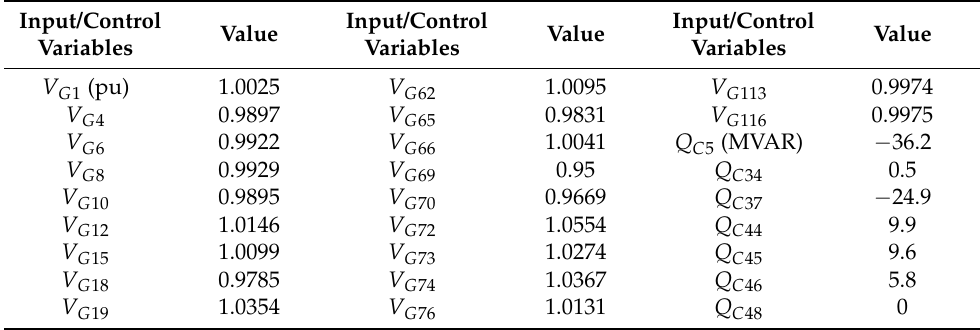
Table A7. Optimal solution obtained by ICOA for TVD objective of the IEEE 118-bus power system with the case of discrete